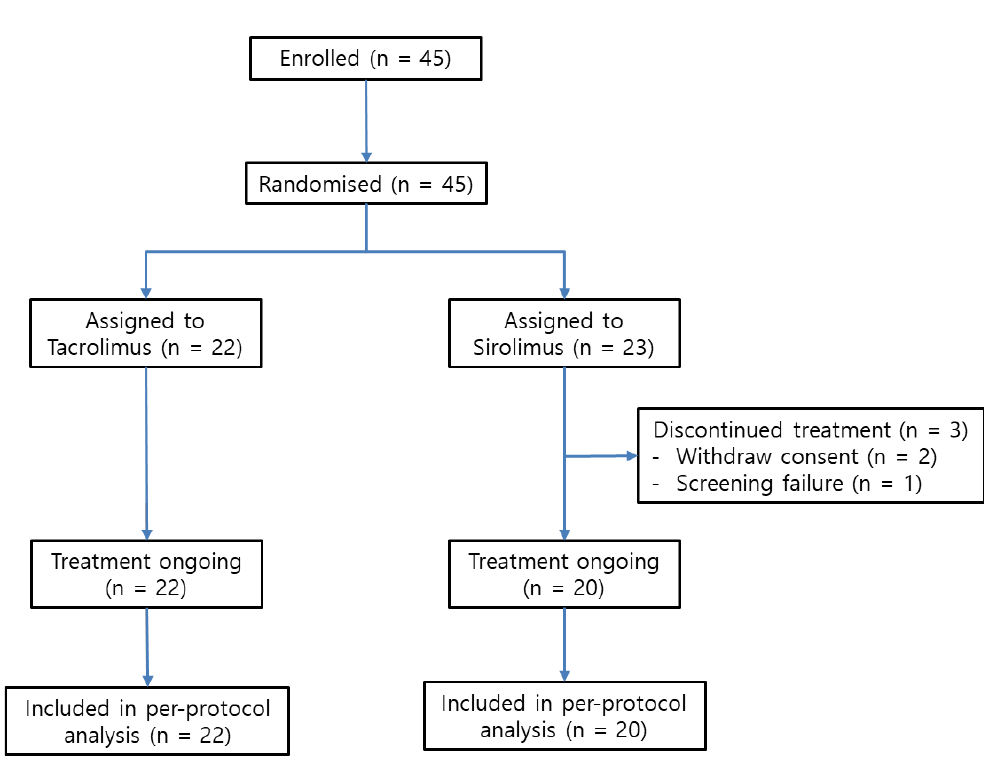
Figure 1. Study flow (CONSORT diagram).